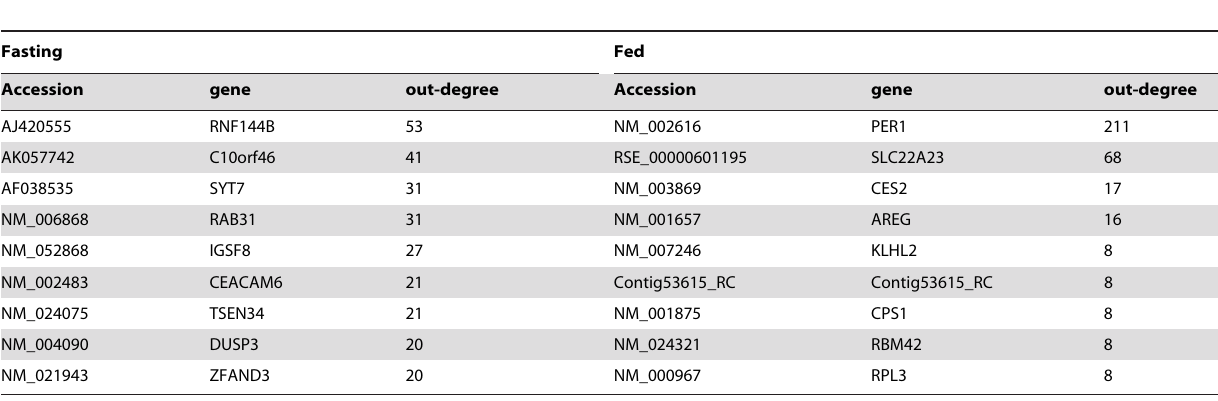
Table 1. Top causal regulators in the fast and fed Granger causality networks.